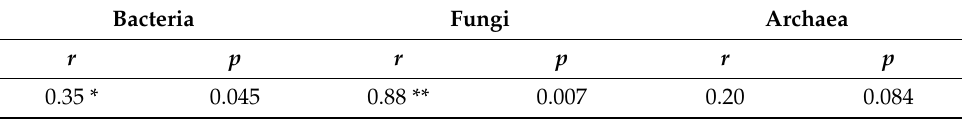
Table 3. Structural differences of microbial community among the three stands at the species level Bacteria